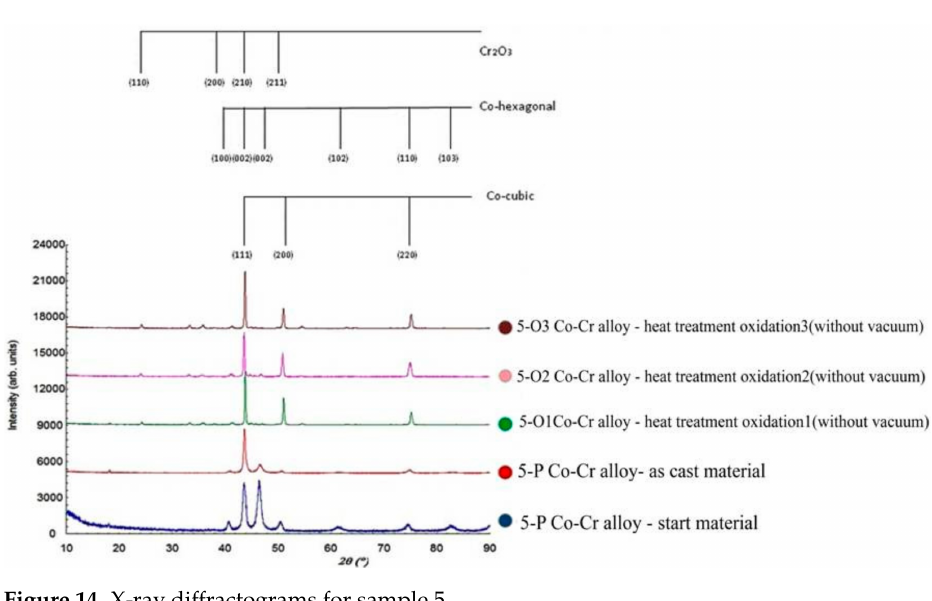
Figure 14. X-ray diffractograms for sample 5.